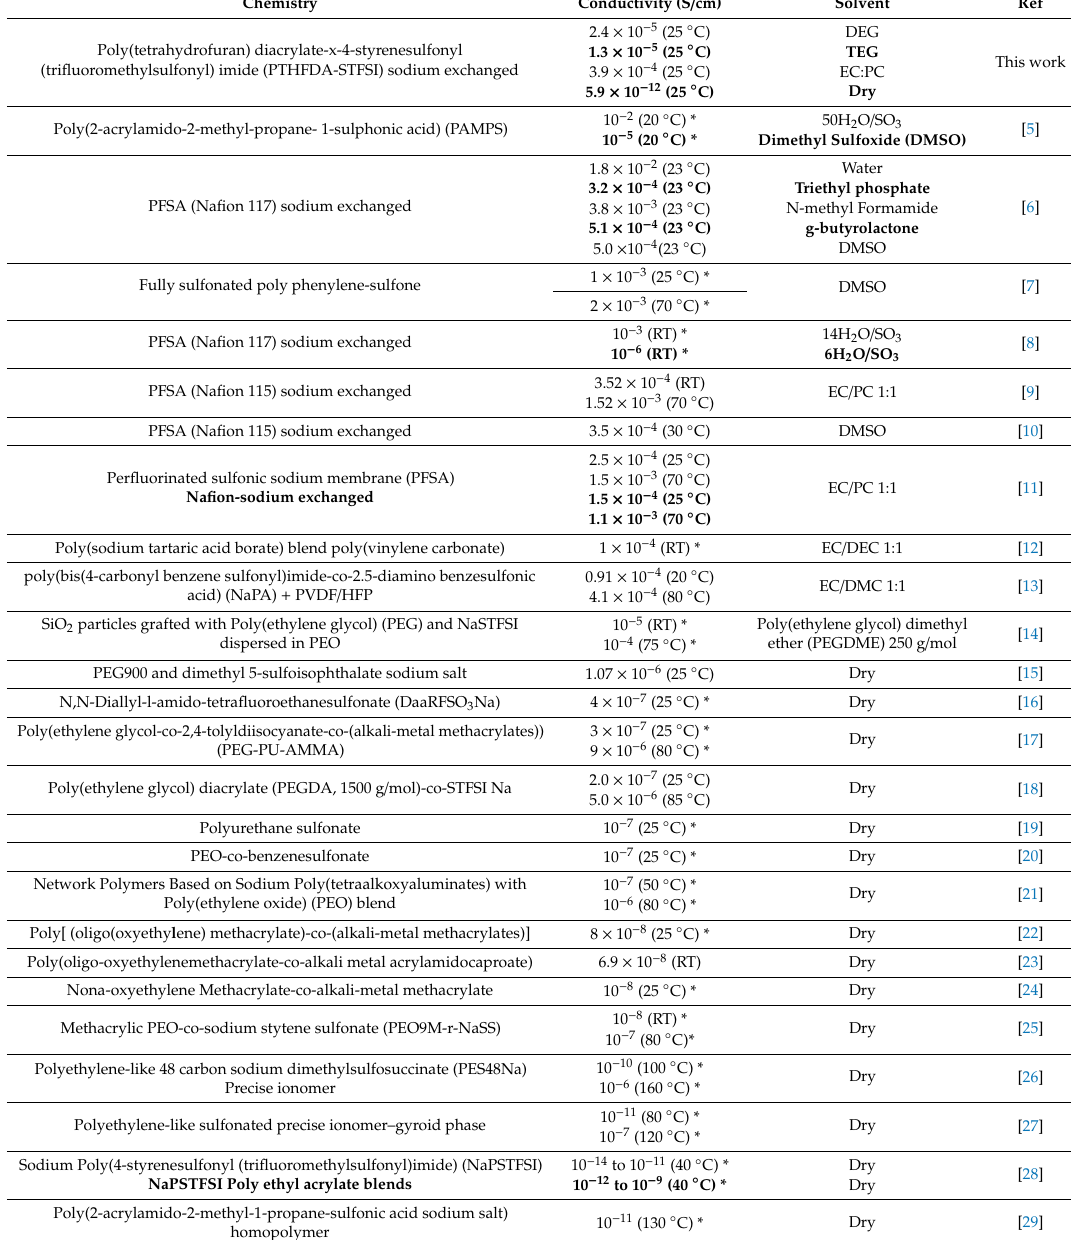
Table 1. Conductivity of sodium exchanged single-ion conducting polymers reported in the literature. * denotes value estimated by visual inspection of plot. Bolded font is for visual guidance, i.e. in the first entry the bold value 1.3 × 10 − 5 goes with the bolded solvent